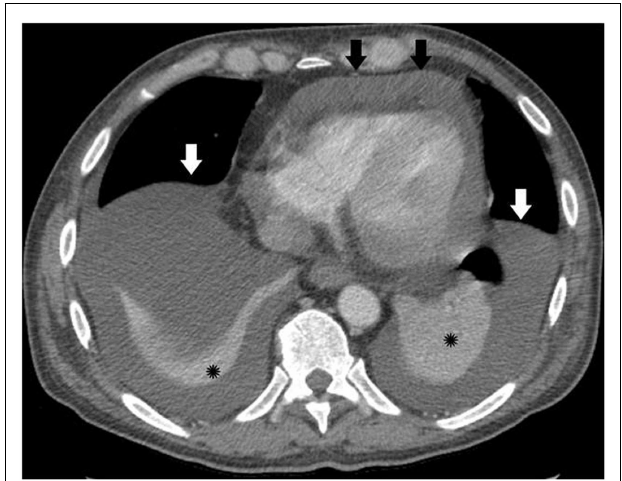
FIGURE 1 | Pre-treatment computed tomography (CT) image with intravenous (IV) contrast, demonstrating bilateral pleural effusions (white arrows) and moderate-sized pericardial effusion (black arrows), prior to thoracentesis, pericardiocentesis, or chemotherapy . Black asterisk = atelectatic lung.